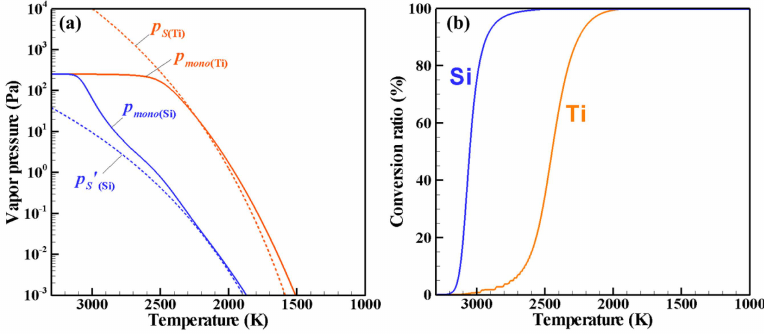
Figure 7. Phase conversion histories for ζ = 10 ´ 3 : ( a ) vapor pressures and ( b ) conversion